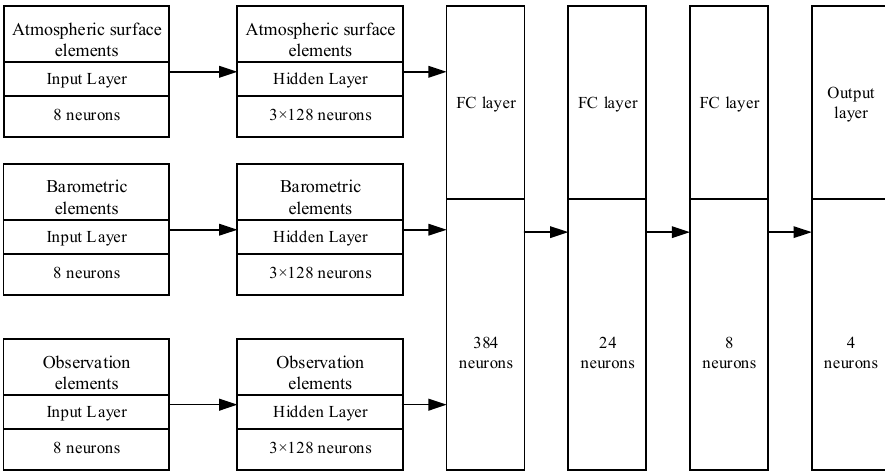
Figure 9. Schematic diagram of neural network structure.